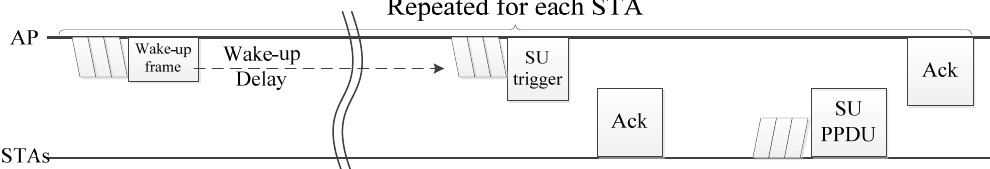
Figure 7. Data transmission procedure to gather the sensed data from sensors operated in application layer based on unicast transmission. SU = single user; SU PPDU = single user physical layer protocol data unit.